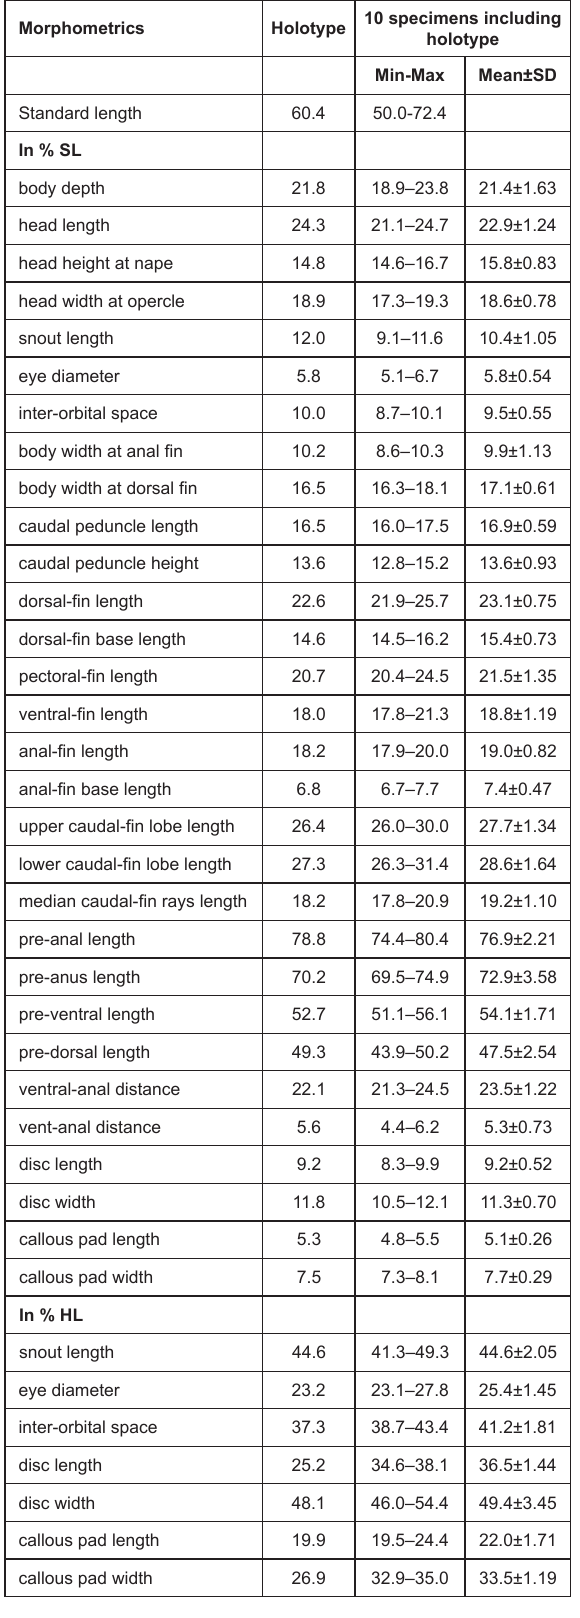
Table 1. Morphometric characters of G. kalpangi sp.